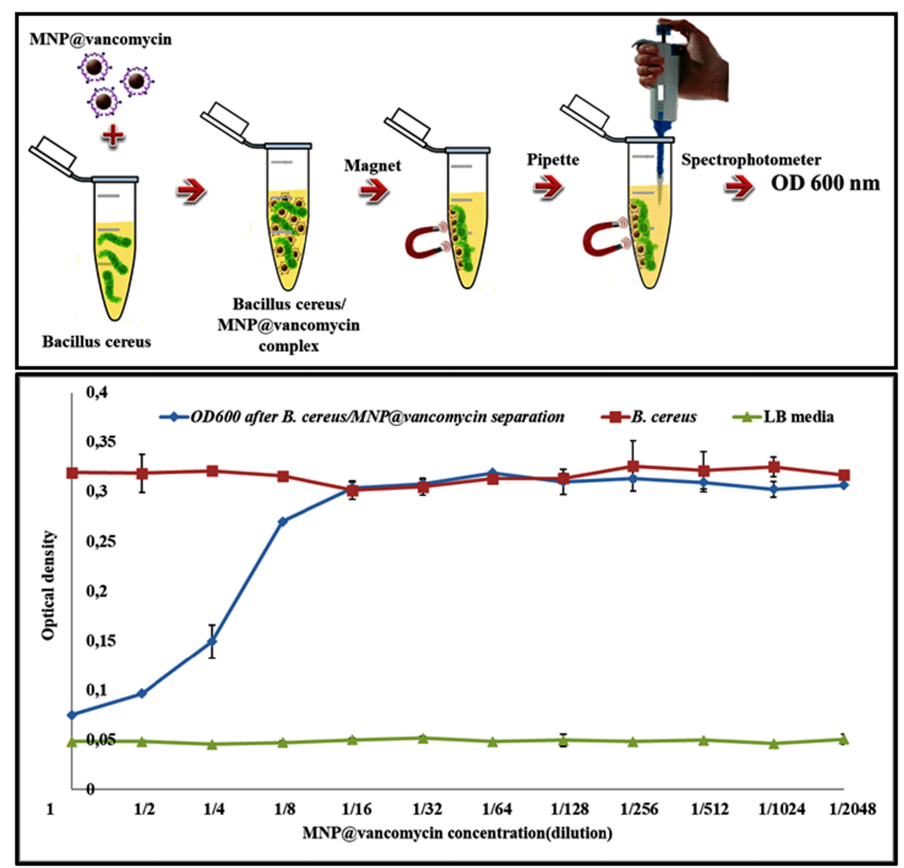
Figure 2. Schematic representation of the steps involved in bacterial separation and media purification using MNP@vancomycin (upper panel). Optical density response measured at 600 nm for a B. cereus -inoculated media (positive control) (red), noninoculated media (negative control) (green), and B. cereus -inoculated media after the magnetic separation of the bacteria using different concentrations of MNP@vancomycin (blue) (lower panel).